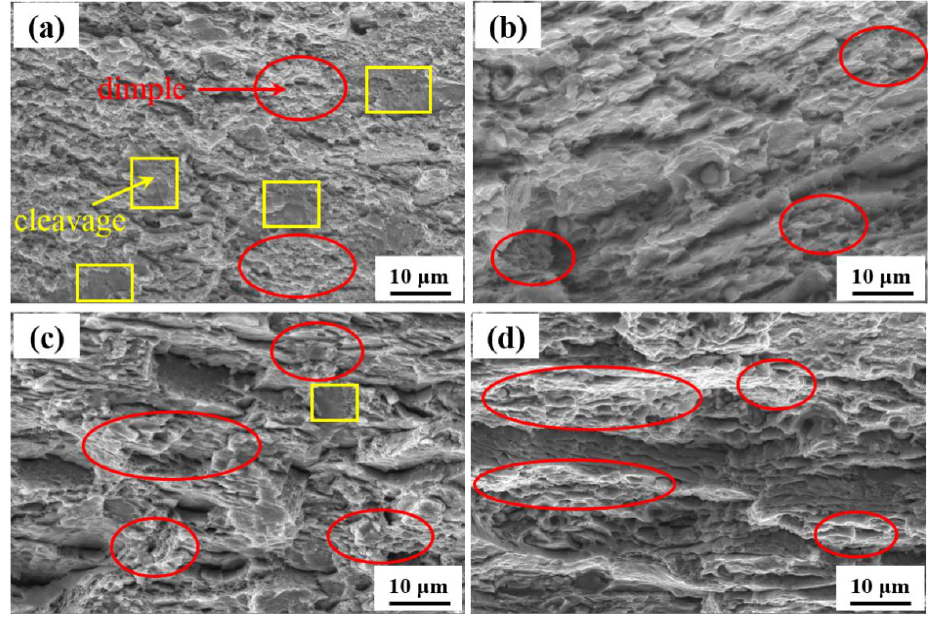
Figure 7. Fracture morphology of the T6 treated alloys with various rolling reductions: ( a ) 64.7%; ( b ) 72.1%; ( c ) 81.4%; ( d ) 88.2%.